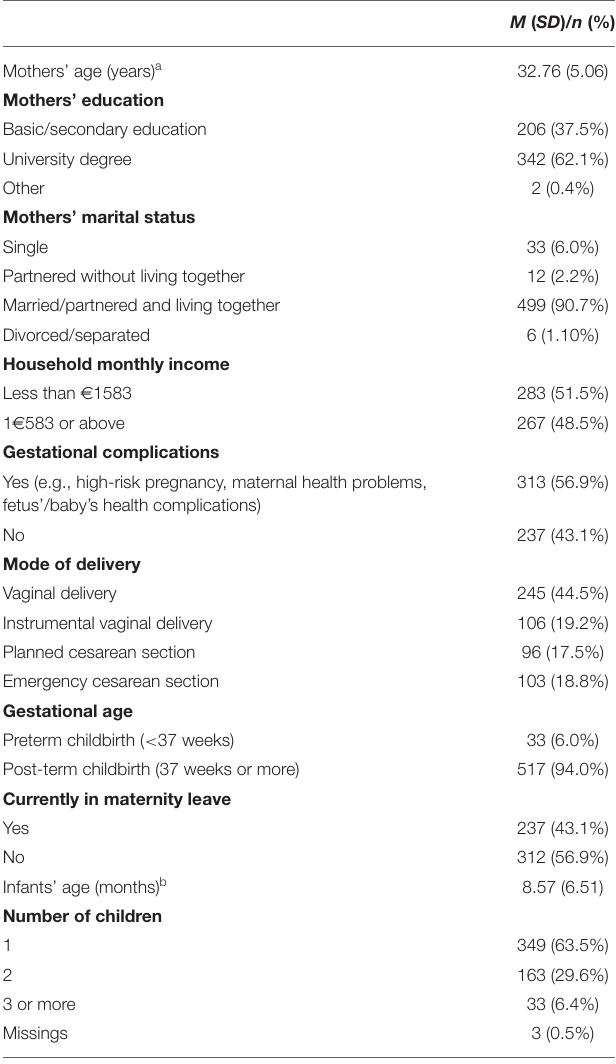
TABLE 1 | Sociodemographic characteristics of the